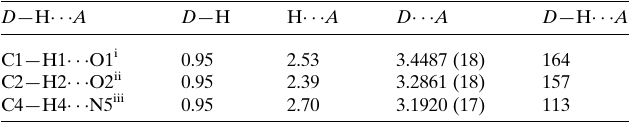
Table 1 Hydrogen-bond geometry (A˚ , (cid:2) ) for 1 .